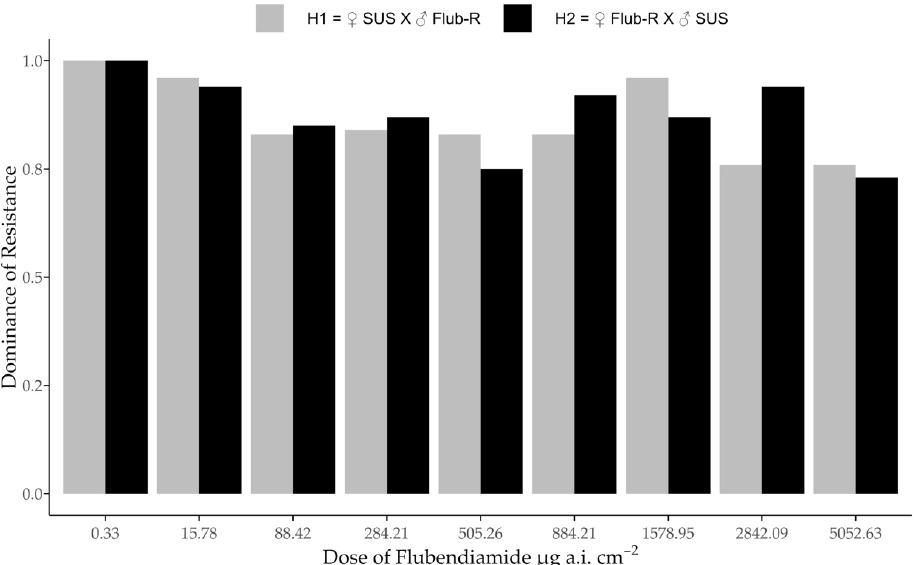
Figure 1. Dominance of resistance to flubendiamide in H. armigera as a function of dose. Reciprocal crosses represented by H1 ( ♀ SUS × ♂ Flub-R) and H2 ( ♀ Flub-R × ♂ SUS).